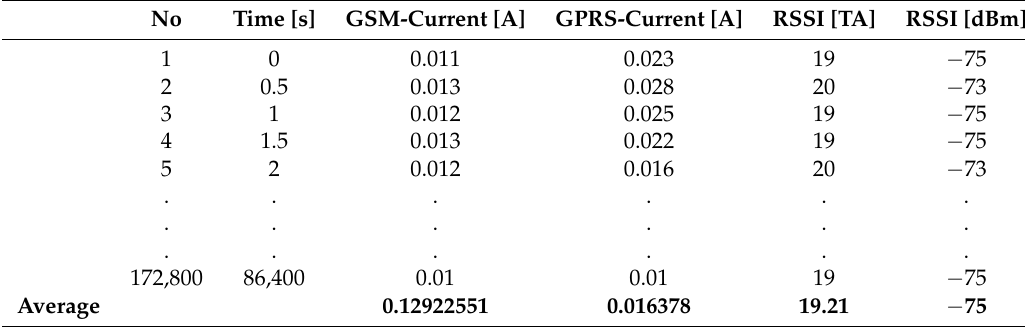
Table 4. Current consumption in location 1, RSSI = − 75 dBm.